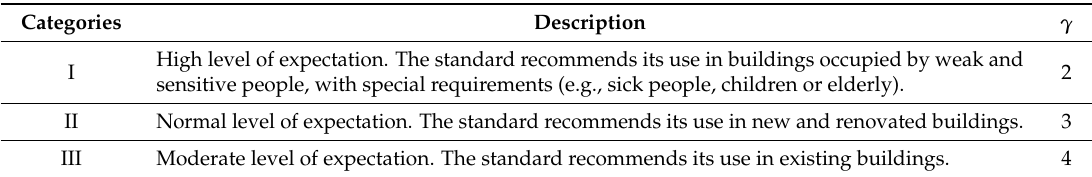
Table 1. Categories of EN 15251 and acceptability